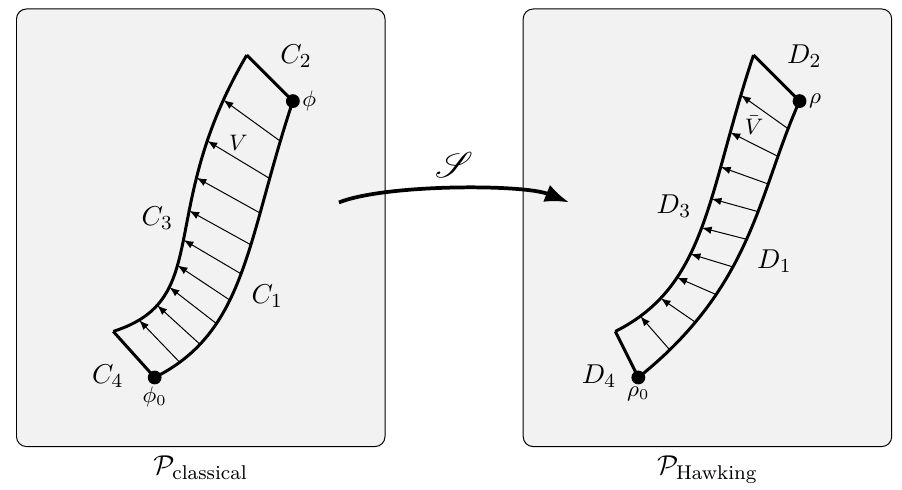
Figure 11. The curves C ⊂ P classical and D = S ( C ) ⊂ P Hawking